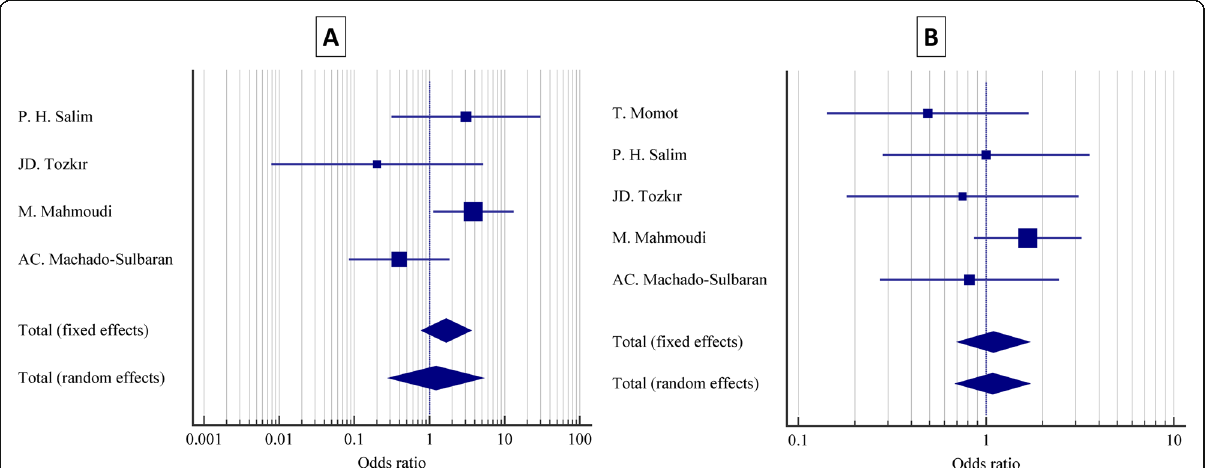
Fig. 2 Forest plot. The plot shows results of pooled OR for ( a ) 2DP1 and ( b ) 3DL1